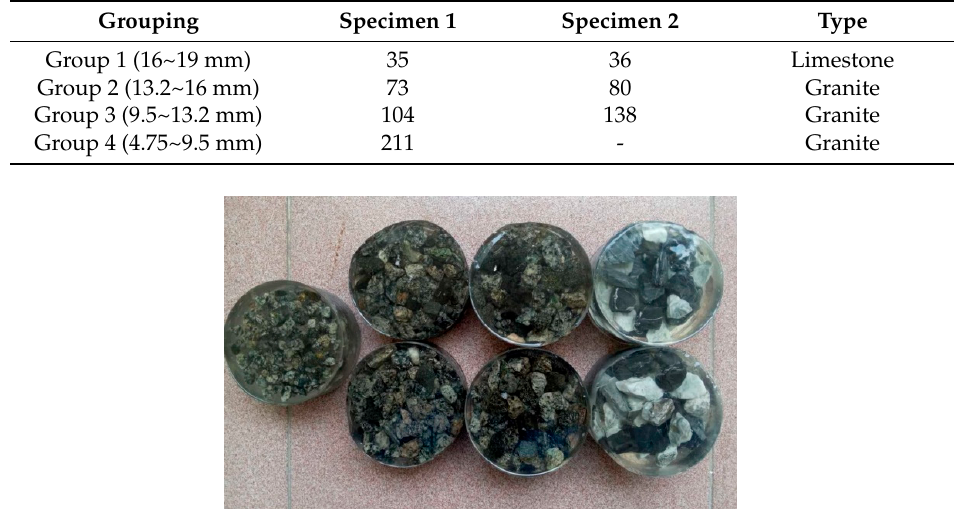
Figure 5. Epoxy-filled aggregate specimens.